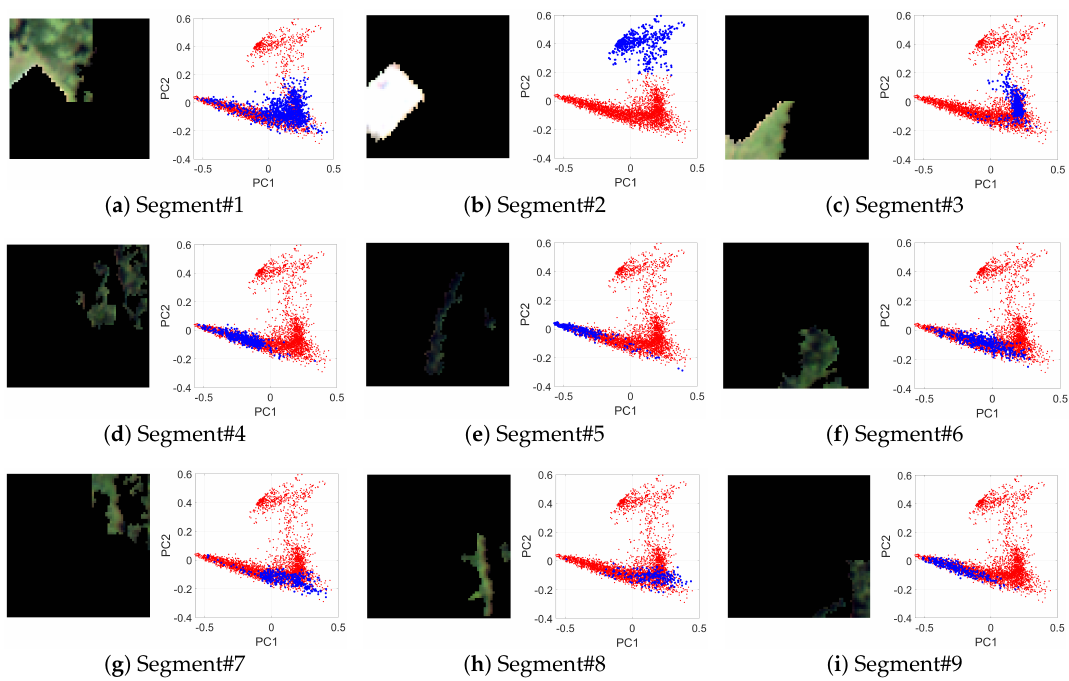
Figure 6. Results of coarse SLIC segmentation and their corresponding location in the scatter plot. In subfigures ( a )–( i ), the left figure corresponds to the spatial segment and the right figure highlights in blue the location of those pixels in the scatter